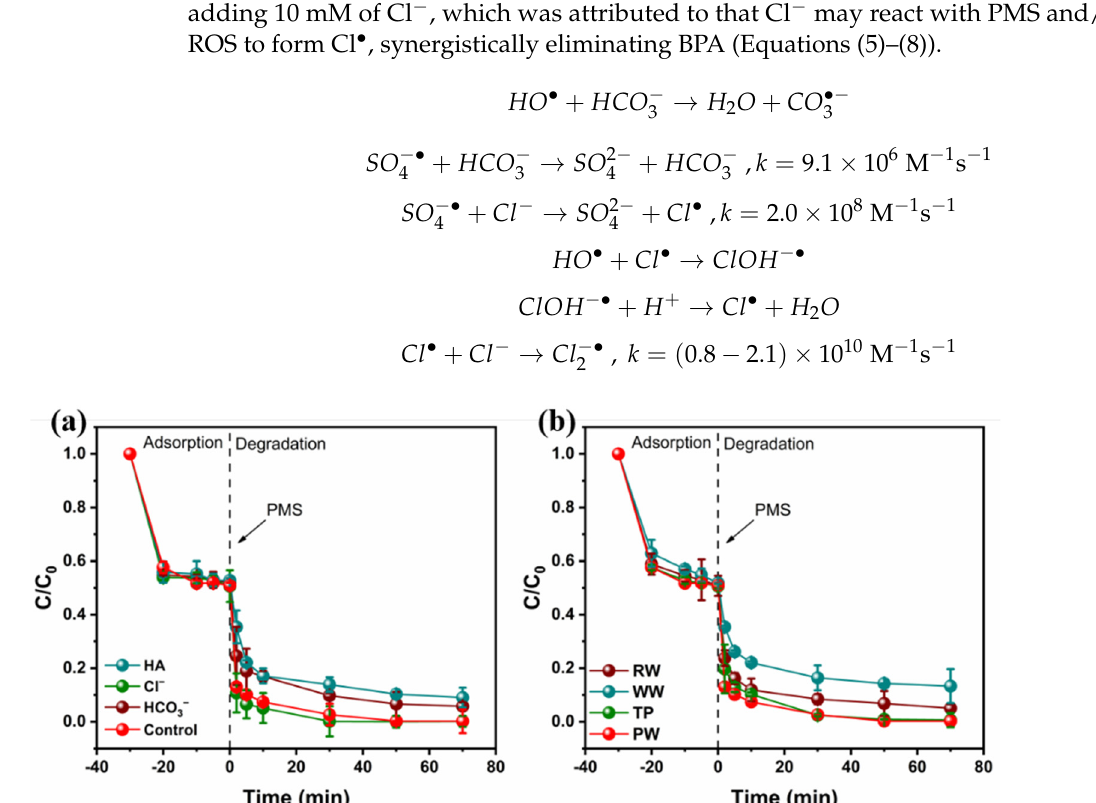
Figure 7. Elimination of BPA in SPFC800/PMS system after adding interfering substances (( a ), i.e., HA, Cl − , and HCO 3 − ) and degradation of BPA in actual water samples; (( b ), i.e., RW, WW, TW, and PW). (Experimental conditions: [BPA] = 10 mg L − 1 , [Oxidant] = 5 mM, [SPFCx] = 0.2 g L − 1 , [HA] = 5 mg L − 1 , and [Cl − 1 ] = [HCO 3 − ] = 5 mM).